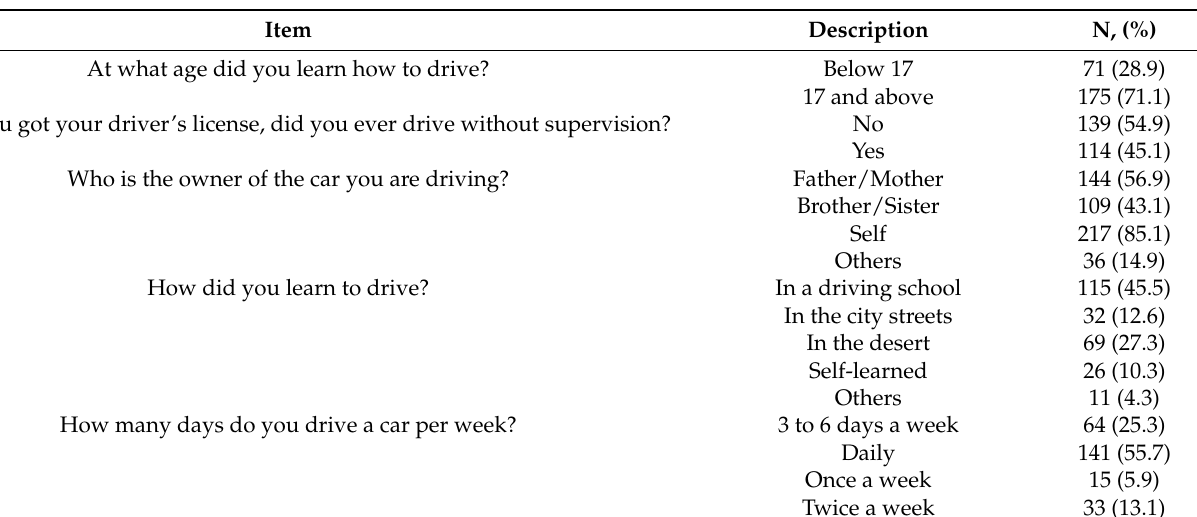
Table 2. Young drivers’ driving history.